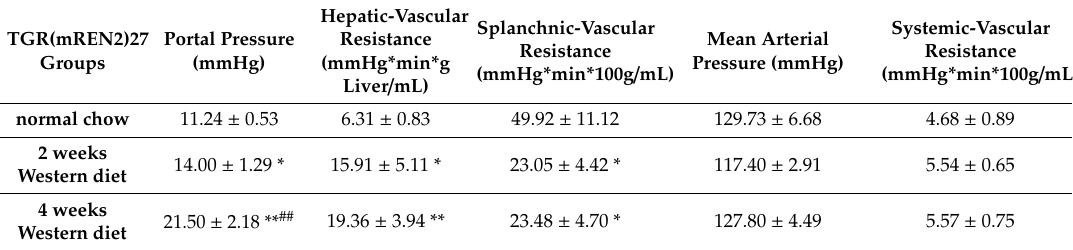
Table 2. Hemodynamics in transgenic TGR(mREN2)27 rats with normal chow vs. 2 and 4 weeks of Western